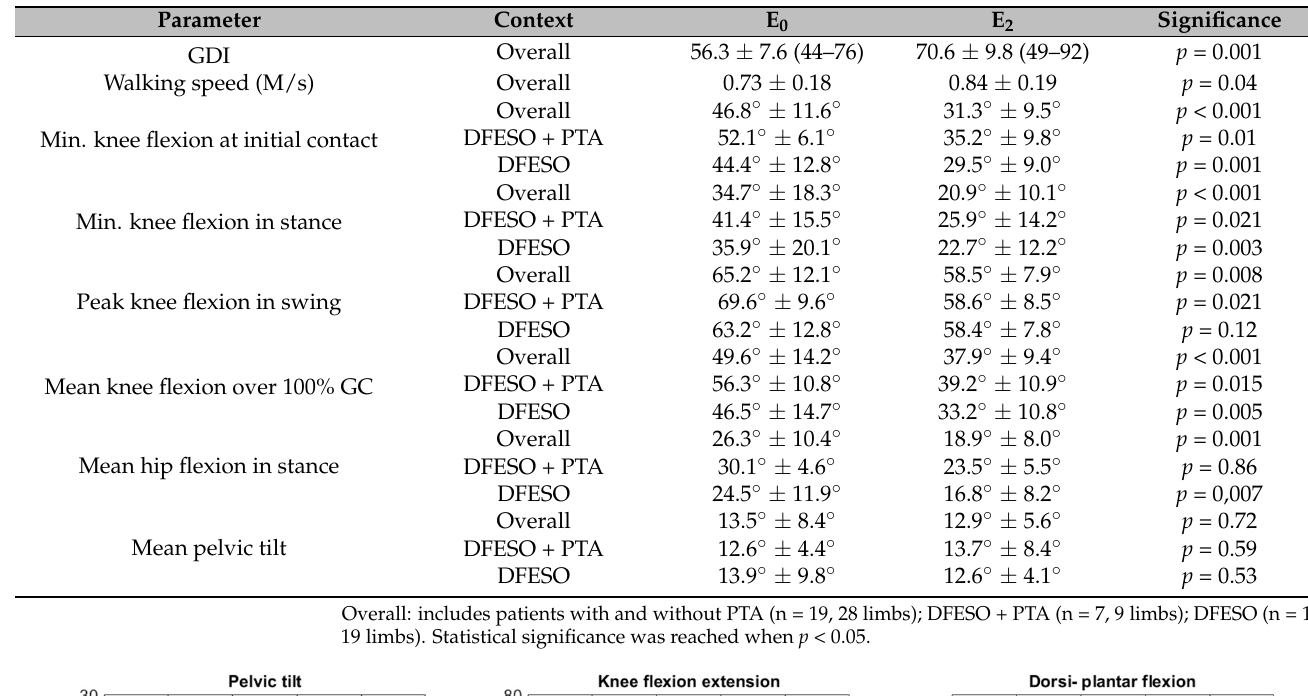
Table 2. Overview of the kinematic parameters at the different time points; E 0 : preoperative; E 2 : 24–60 months postoperative.